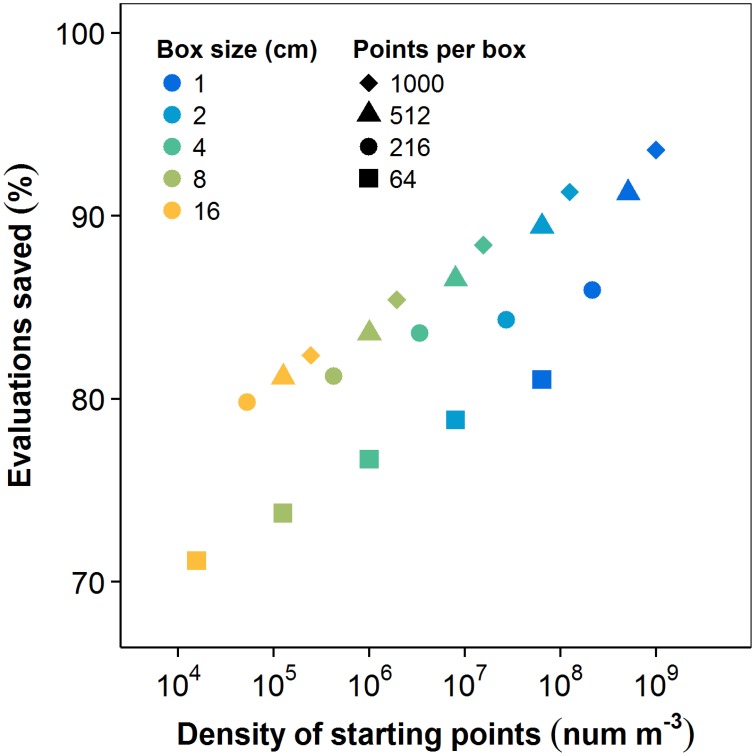
Box-count evaluations eliminated by including the history function, as a function of the starting point density (npts∕s3). The density of starting points, and thus the time savings due to elimination of redundancy, increase separately with increasing number of starting points and decreasing box size.